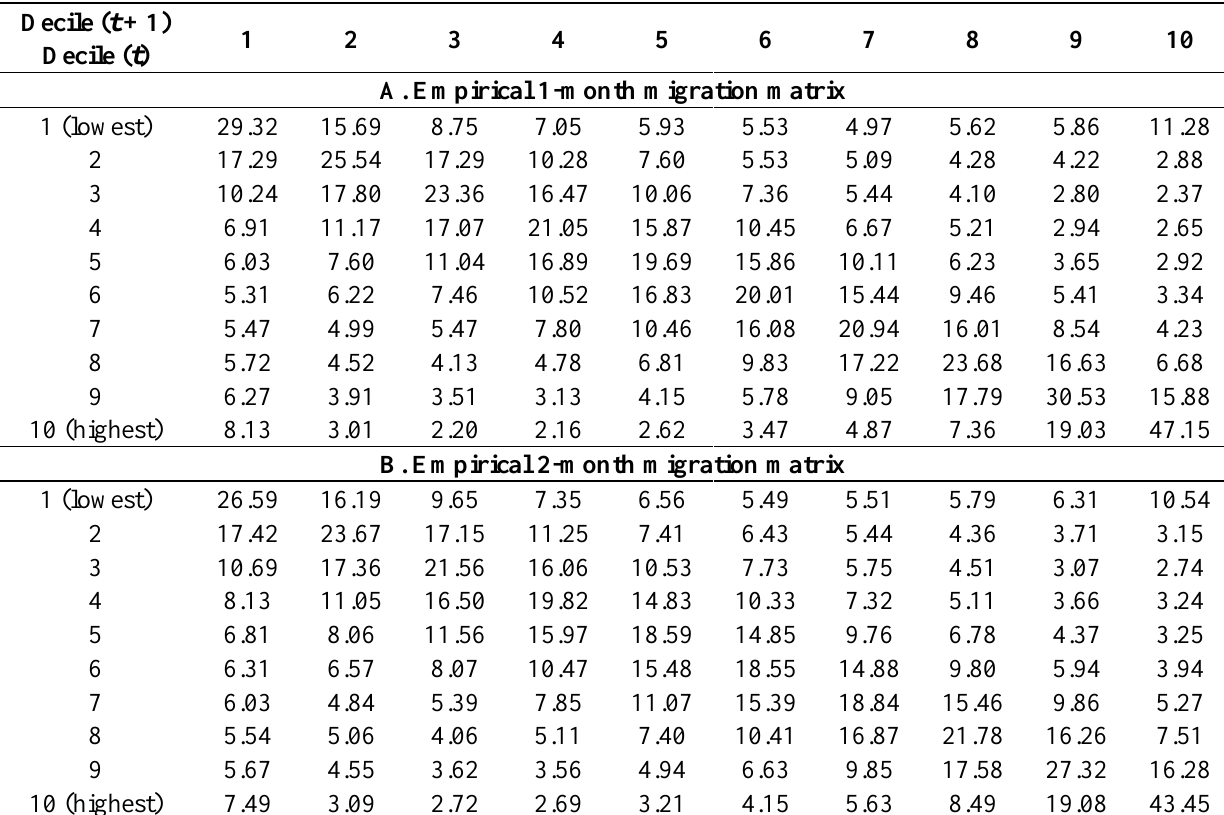
Table 7. Empirical migration matrices between flow deciles, small-cap equity funds. Decile ( t +